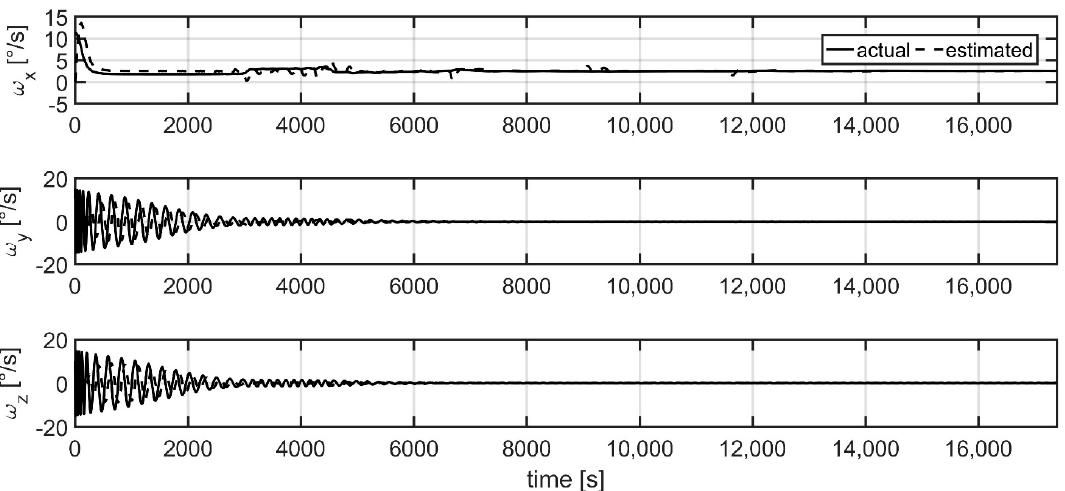
Figure 5. Difference between the actual and estimated angular rates for Test Case 1.